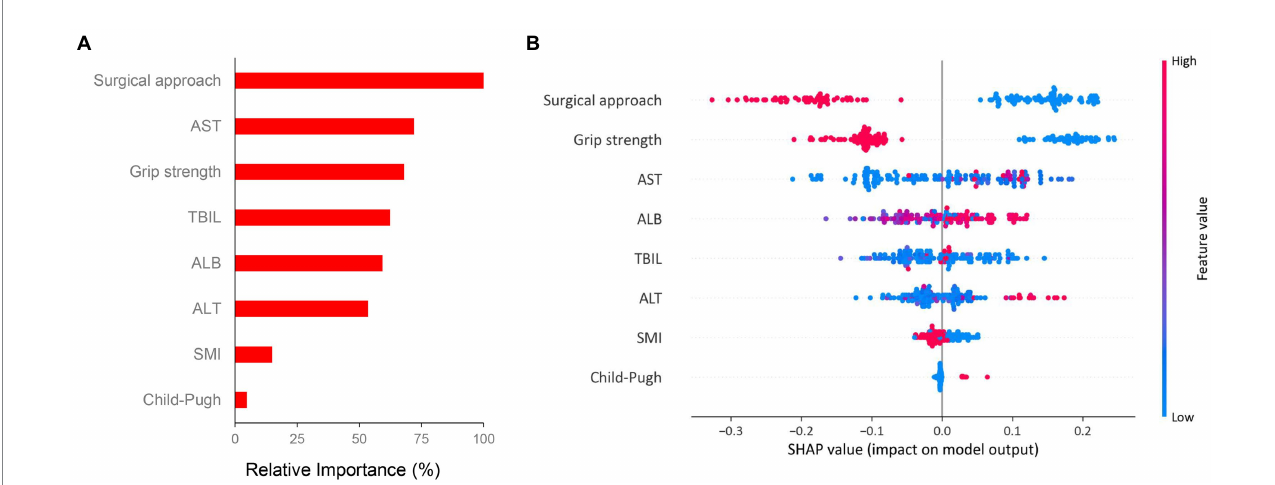
FIGURE 4 Importance matrix plot and SHAP summary plot of eight clinical features associated with major complication. (A) The importance ranking of eight clinical features using the random forest algorithm and (B) The SHAP summary plot of the eight feature clusters. Each patient is allocated one dot on the line for each feature and the dots are colored based on the values of features. Red indicates higher feature values and blue indicates lower feature values. A feature’s SHA p value (x-axis) represents the contribution of the specific feature to the risk of major complication. The higher SHAp value of a feature is given, the higher risk of postoperative major complication the patient would have. Abbreviations: SHAP, Shapley additive explanation; SMI, skeletal muscle index; TBIL, total bilirubin; ALB, albumin; ALT, alanine aminotransferase; AST, aspartate